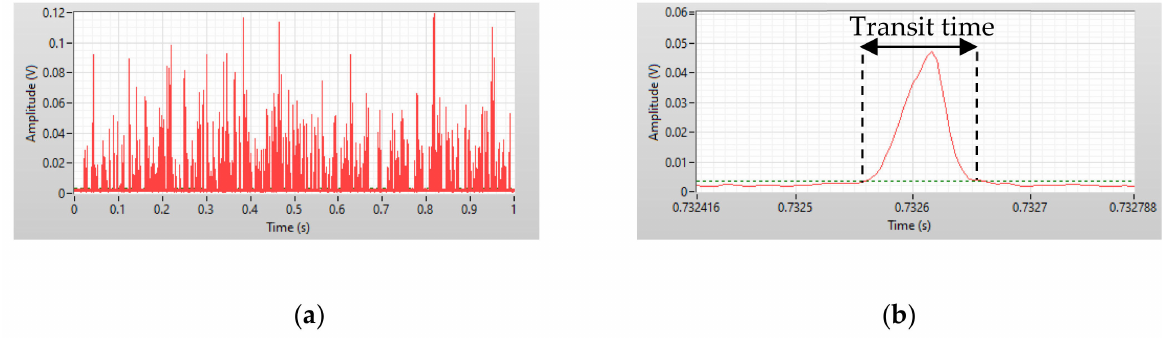
Figure 3. ( a ) One second of data recorded by the LabView program. ( b ) A detailed view of the pulse produced when particles passed through the interrogation